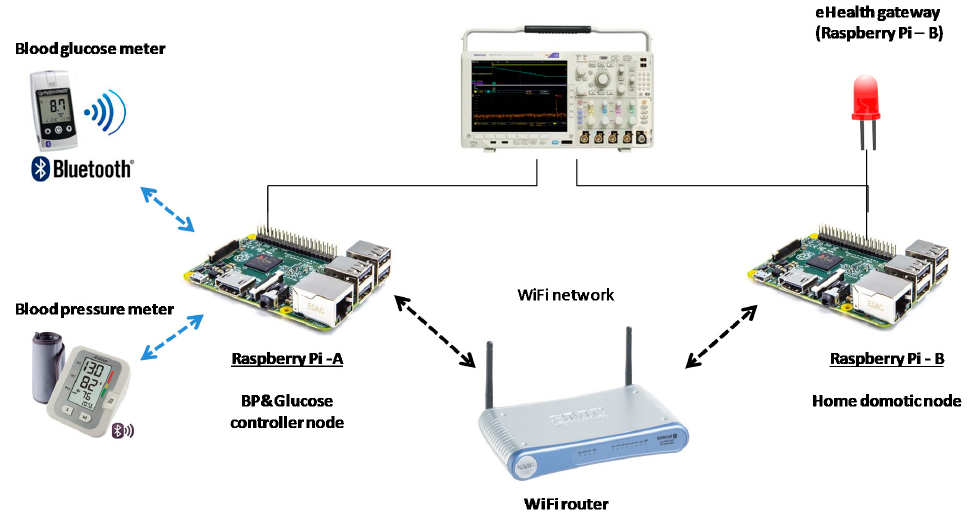
Figure 17 . Security performance demonstrator. Figure 17. Security performance